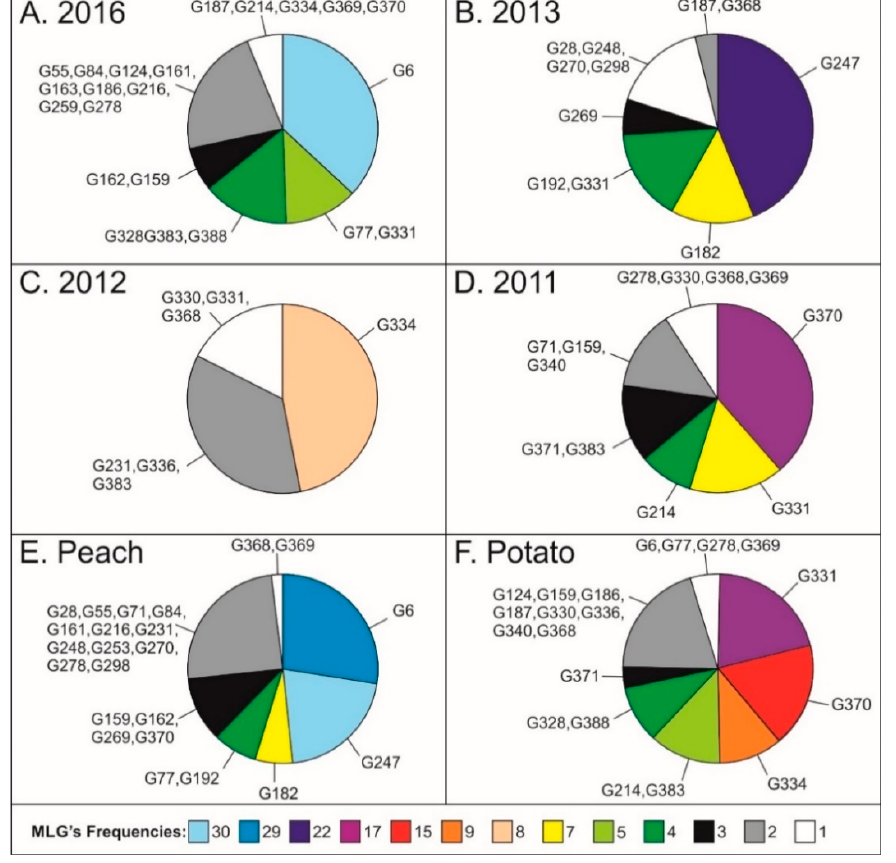
Figure 2. Distribution of the commonest genotypes of M. persicae according to ( A–D ) the sampling year; ( E,F ) host plant.